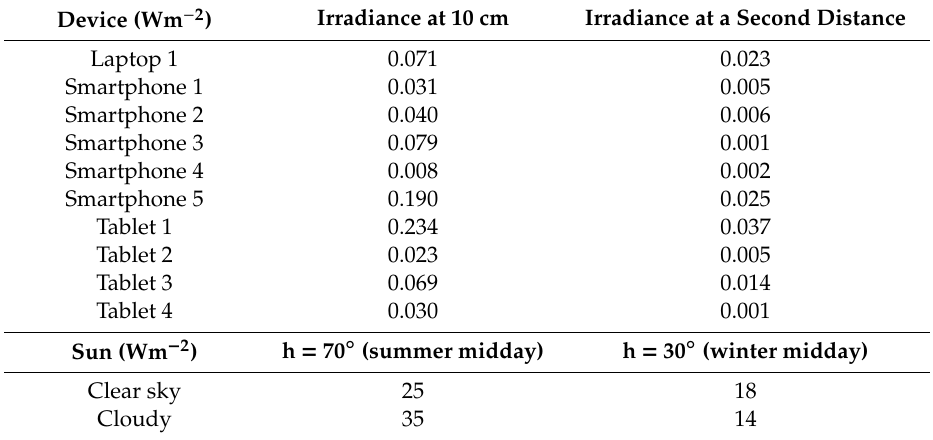
Table 1. Weighted irradiances for blue light hazard from 380 to 600 nm at 10 cm and at 35 / 40 cm (smartphones / tablets) for the di ff erent electronic devices and the estimated solar di ff use irradiances for blue light hazard under four di ff erent atmospheric conditions (solar height, h and